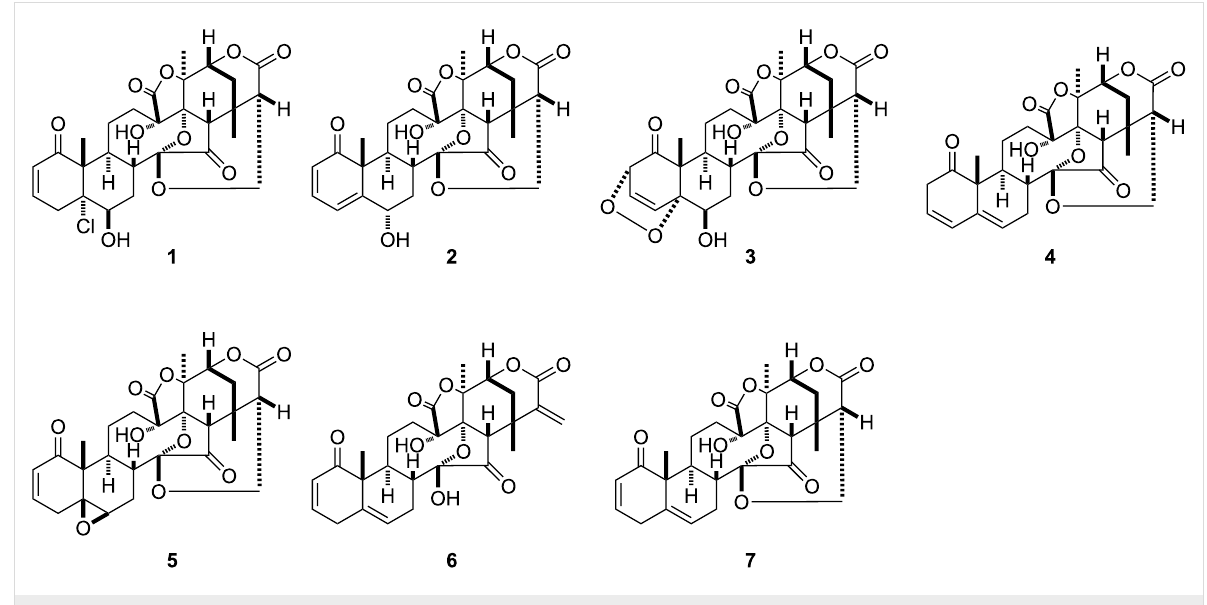
Figure 2: Isolated compounds from Solanum nigrum